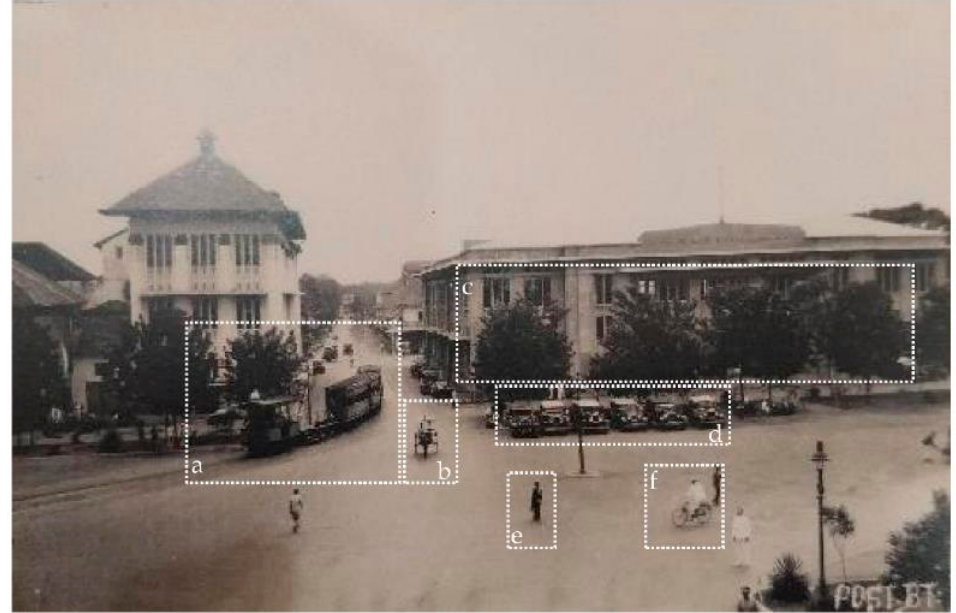
Figure 10. Fatahillah Square heading to North in 1930. Identified sound sources: ( a ) tram. ( b ) Horse-drawn carriage. ( c ) trees as natural sound. ( d ). vehicles. ( e ). Human voice. ( f ) a bicycle. Source: Greetings from Jakarta: Postcards of a Capital 1900–1950.